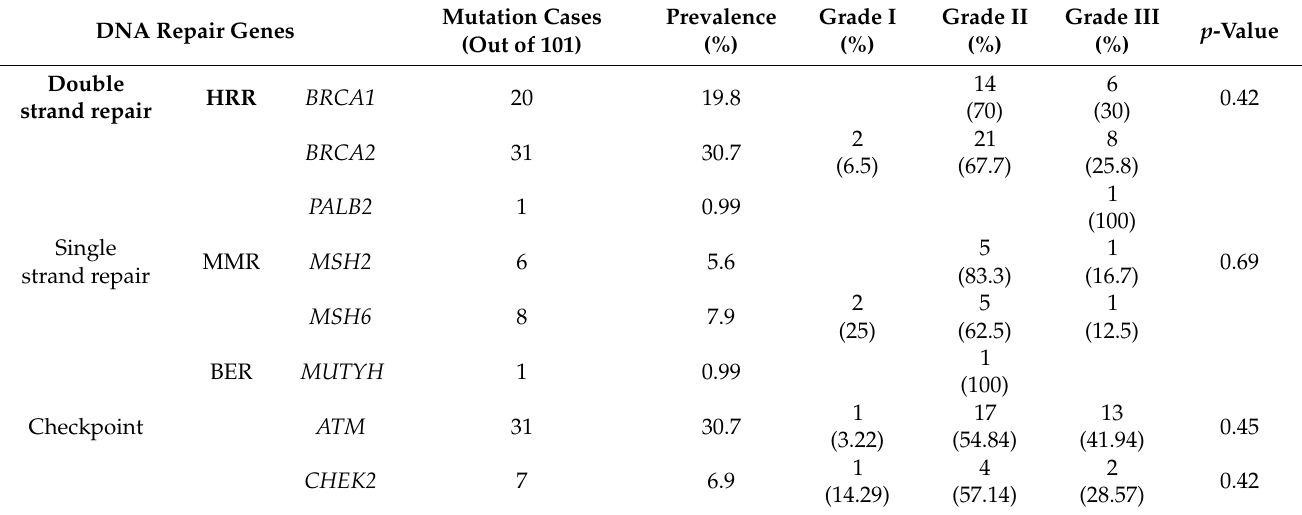
Table 3. Prevalence of germline mutations in DNA repair genes and among different tumor